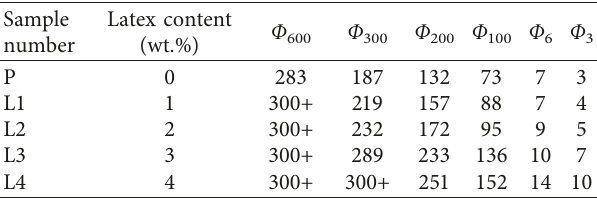
Table 2: Dependence of latex powder content on